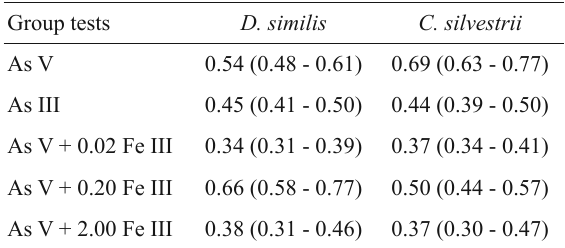
EC50 mean values (mg L -1 ) and 95% con fi dence intervals (in parentheses) for C. silvestrii and D. similis for As III and As V isolated and associated with Fe.